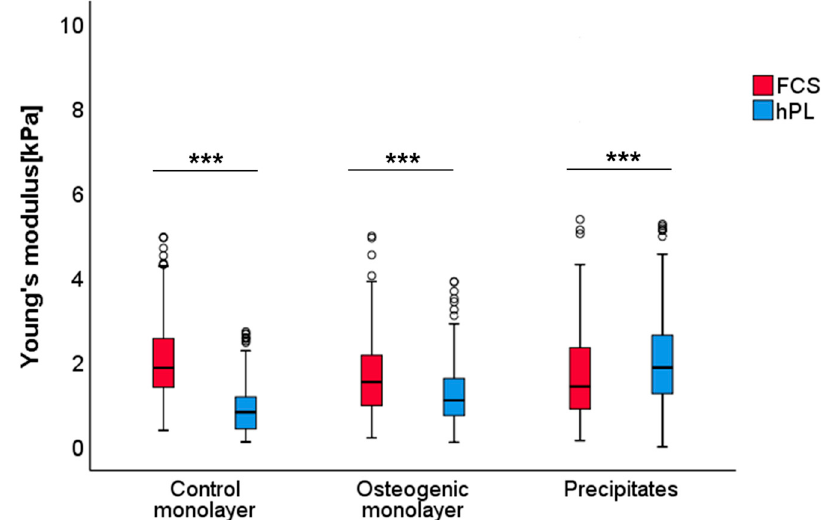
Figure7. AnalysisofYoung’smodulusofJPCmonolayersculturedunderFCSandhPLsupplementation. Figure 7. Analysis of Young’s modulus of JPC monolayers cultured under FCS and hPL Boxplots (medians, minimum, maximum) of the sti ff ness (kPa) measured by atomic force microscopy supplementation. Boxplots (medians, minimum, maximum) of the stiffness (kPa) measured by for each analyzed group are depicted. In both, control (untreated) and osteogenic monolayers of atomic force microscopy for each analyzed group are depicted. In both, control (untreated) and FCS cultured monolayers analyzed ECM revealed higher sti ff ness when compared to hPL groups. osteogenic monolayers of FCS cultured monolayers analyzed ECM revealed higher stiffness when The reversed e ff ect was observed for the group of precipitates. *** p < 0.001 (for exact p -values, see compared to hPL groups. The reversed effect was observed for the group of precipitates. Table 3). Abbreviations: FCS—fetal calf serum, hPL—human platelet